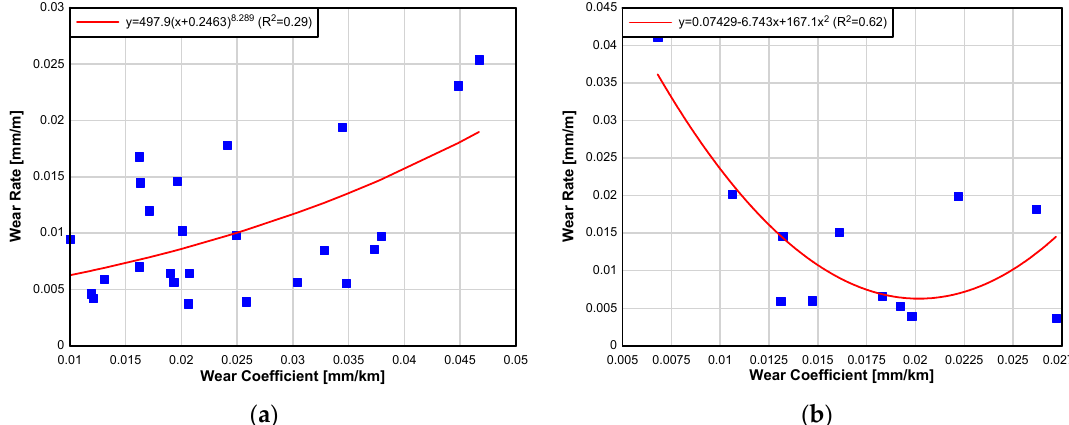
Figure 13. Correlation between the wear coefficient and the wear rate: ( a ) weathering grade G(I) to G(IV) ground; ( b ) G(V) and mixed ground.